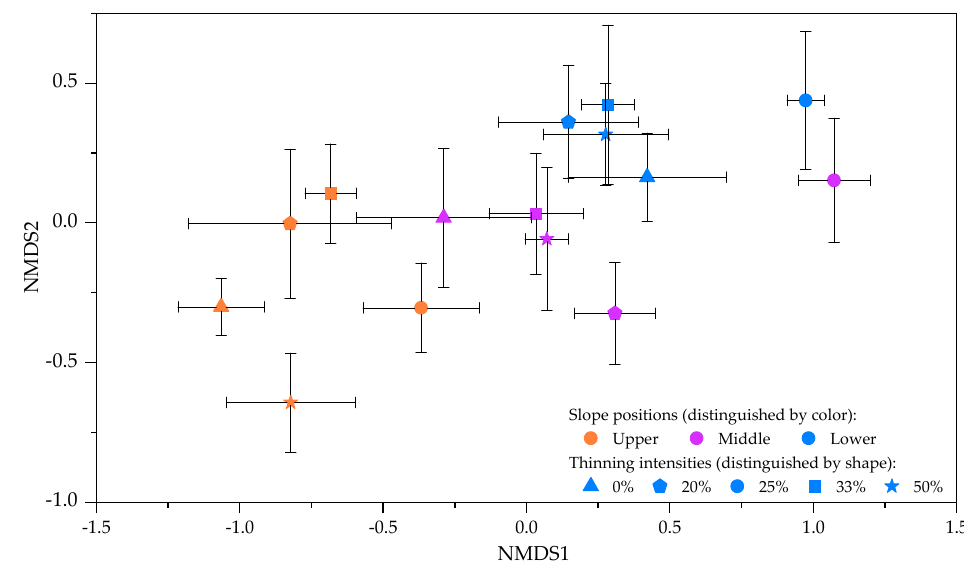
Figure 5. Non-metric multi-dimensional scaling (NMDS) ordinations of dissimilarities of AMF communities on different plots with the data of OTU composition (Bray–Curtis distance). Values are means ± standard errors.